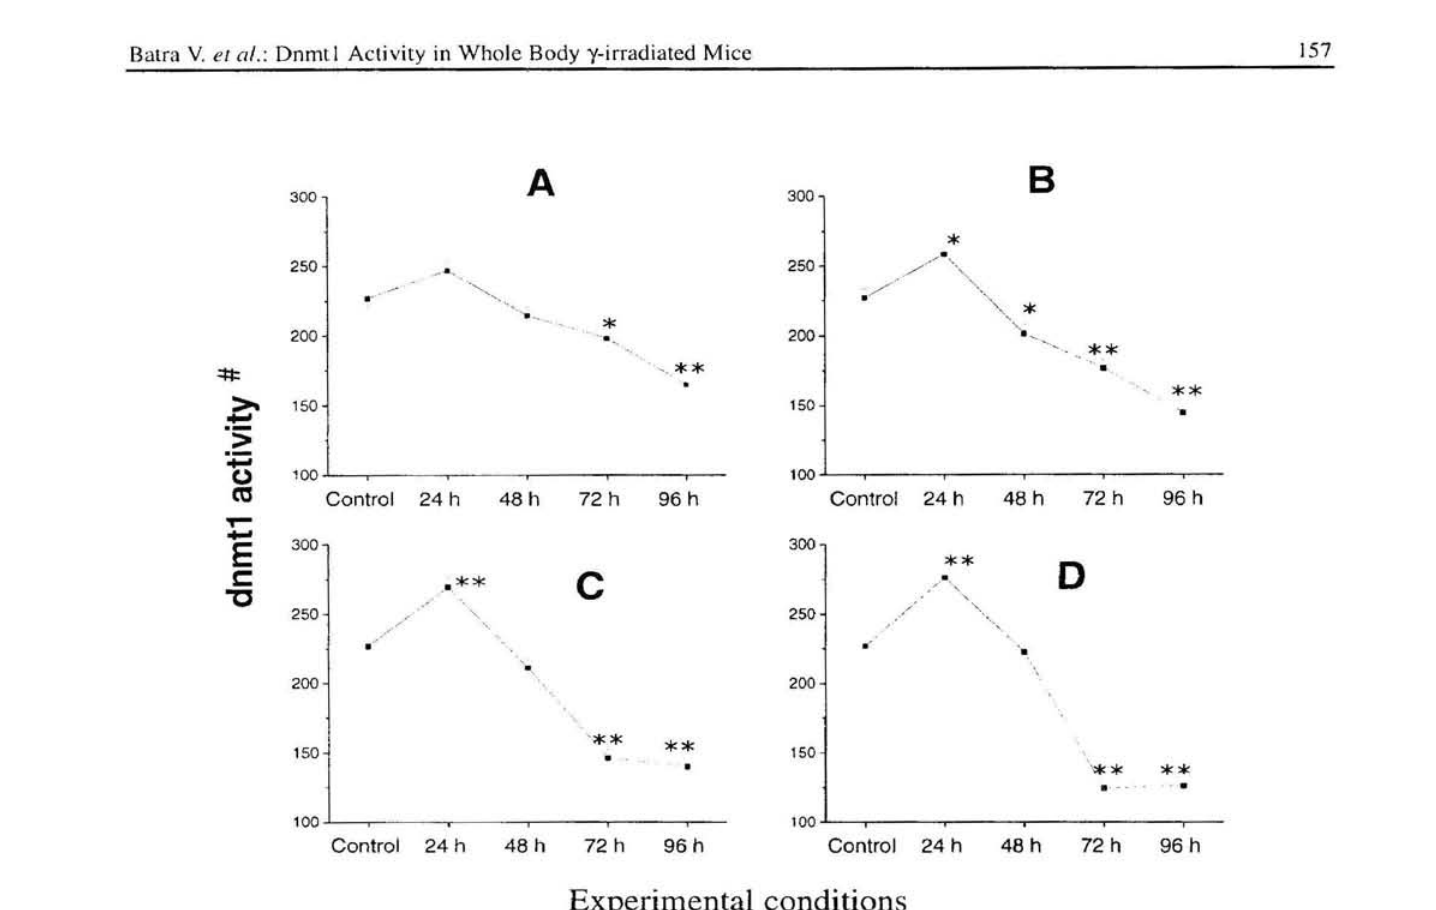
1. Modulation of nuclear dnmtl activity at various time intervals after different doses of gamma irradia- tion. A: 1 Gy B: 3 Gy C: 5 Gy D: 7 Gy. # The activity is expressed as femtomole of methyl group transferred /mg protein /hour and the values are mean ± Standard error of samples (in triplicate) from 4 animals in each group. ( * P< 0.05, * * P<